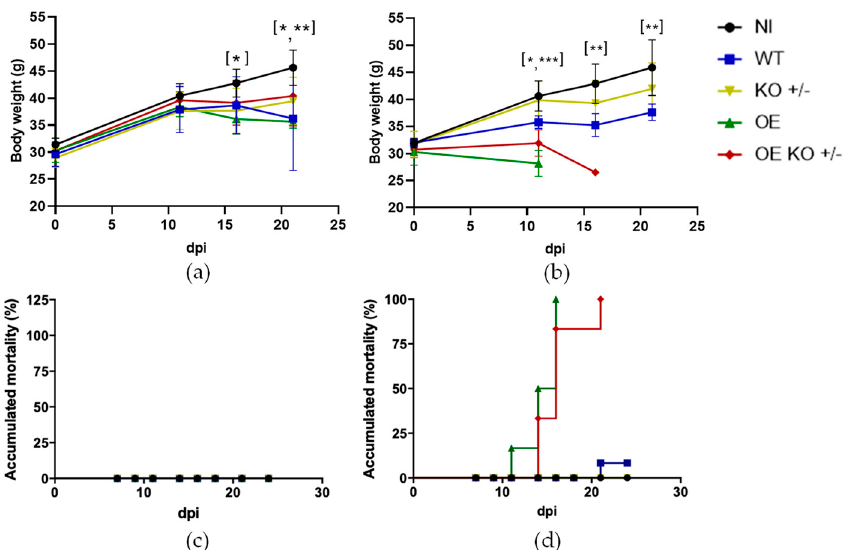
Figure 2. Body weight of animals infected with T. cruzi hemi-knockout or overexpressing the TcNTPDase-1 gene. Mice non-infected (NI) or infected with (wild type) WT, (overexpressed) OE, (hemi-knockout) KO +/ − , and (overexpressed hemi-knockout) OE KO +/ − were followed up to 21 days after infection. ( a ) Body weight variation of infected mice with 10 6 par/animal. * p < 0.05 at 16 dpi (NI vs. OE) and at 21 dpi (NI vs. OE KO +/ − ); ** p < 0.01 at 21 dpi (NI vs. OE). ( b ) Body weight variation of infected mice with 10 7 par/animal. At 11 dpi * p < 0 .05 (NI vs. WT; KO vs. WT; WT vs. OE KO; OE KO vs. OE) and *** p < 0.001 (NI vs. OE; NI vs. OE KO; KO vs. OE; KO vs. OE KO; WT vs. OE). At 16 dpi ** p < 0 .01 (NI vs. WT). At 21 dpi ** p < 0.01 (NI vs. WT). ( c ) Monitoring of accumulated mortality in infected animals until 30 dpi with inoculum of 10 6 par/animal, 100% survival. ( d ) Monitoring of accumulated mortality in infected animals until 30 dpi with inoculum of